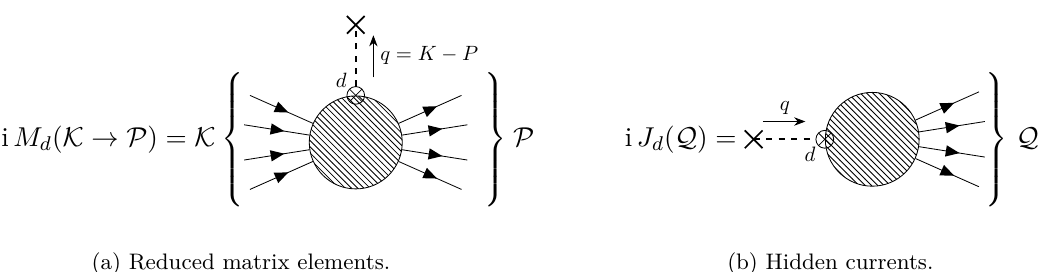
Figure 1. Diagrams for computing the reduced matrix elements M d and the hidden currents J d . Both are given as the sum of all available connected and amputated Feynman diagrams with the appropriate number and kind of particles in the initial and final states. The crossed dot denotes the required portal vertex, and the dashed line denotes the relevant missing momentum in- and outflow. Aside from this portal vertex, diagrams for M d diagrams only contain vertices and propagators associated with visible fields and interactions, while diagrams for J d only contain vertices and propagators associated with hidden fields and